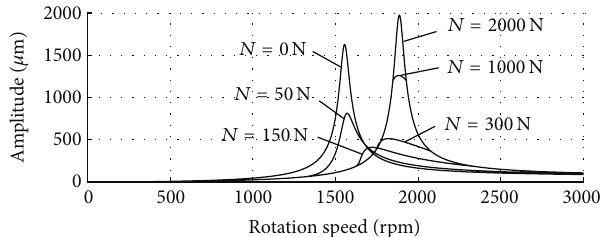
Figure 5: The amplitude-frequency diagram of the rotor under different pressing forces.